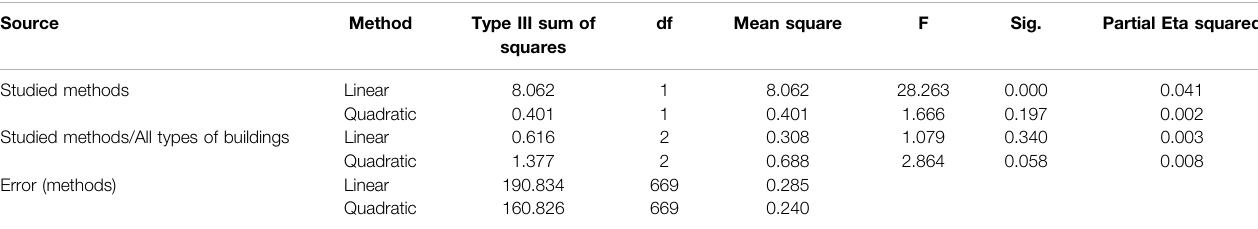
Table 4 is related to the box statistics test. This statistic tests the hypothesis that the observed covariance matrix of dependent variables (methods) is equal between different construction groups. In Table 4 , the probability value is less than 0.05, which means that the null hypothesis is rejected. This means that the observed covariance matrices are not equal between different groups. That is, the methods vary between different construction groups.